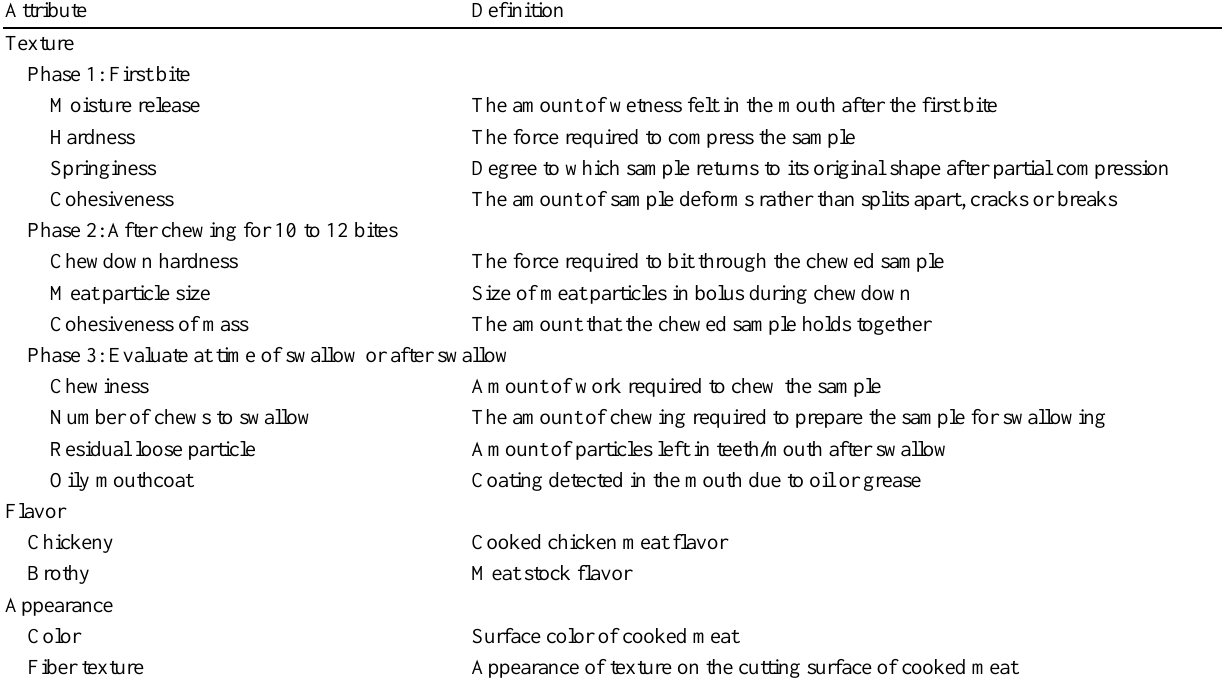
Table 1. Sensory attributes and definitions used by the descriptive analysis panel to evaluate test samples